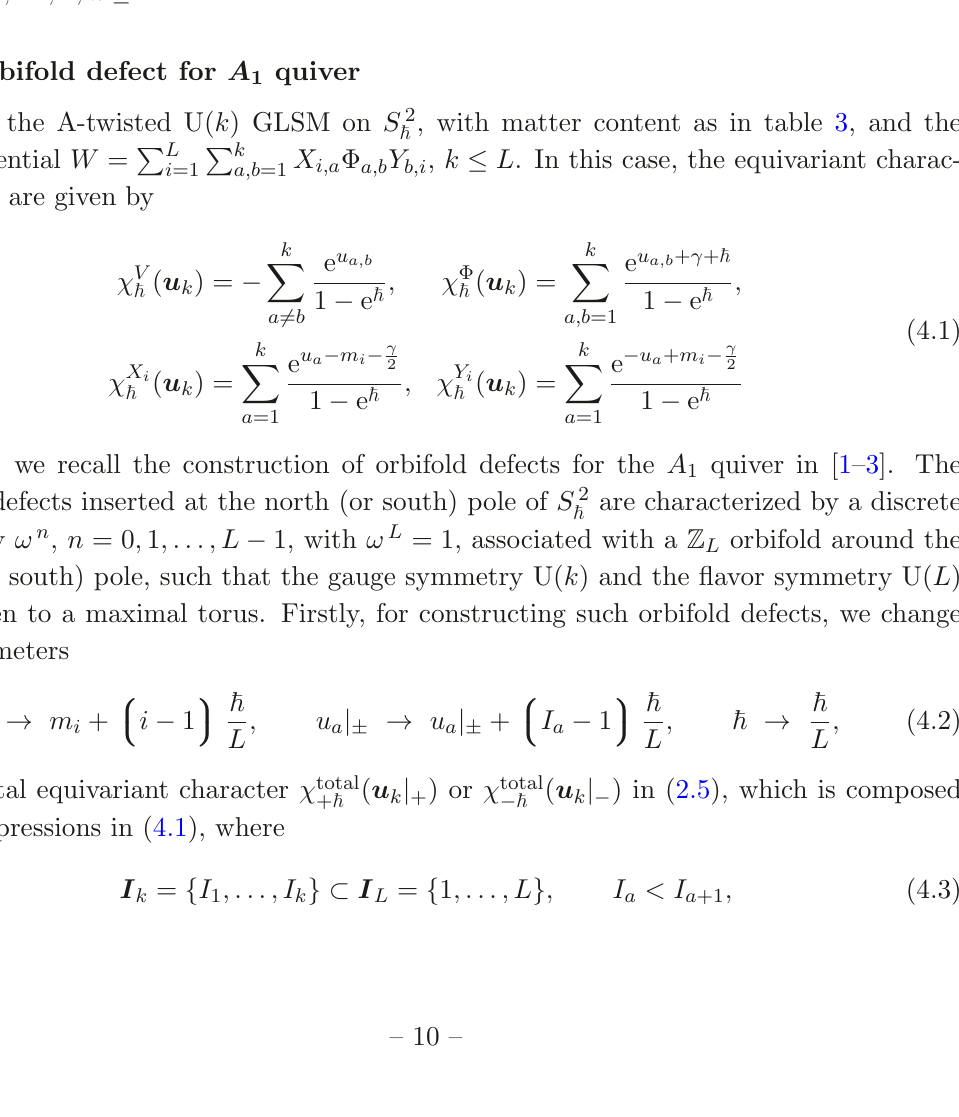
Table 3 . The matter content of the A 1 quiver gauge theory that corresponds to the su (2) spin-chain. Here i = 1 , . . . , L , k ≤ L